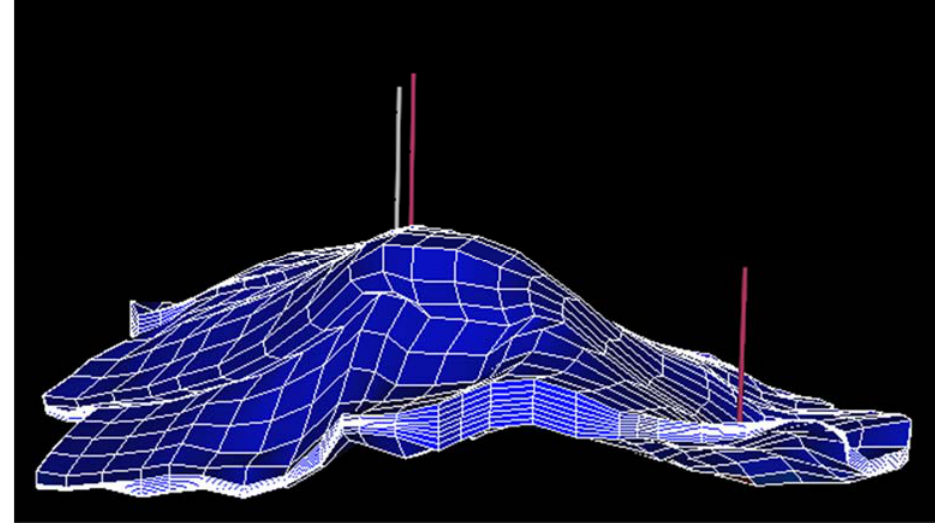
Figure 4. Visualization of the analyzed reservoir structure and location of the wells.